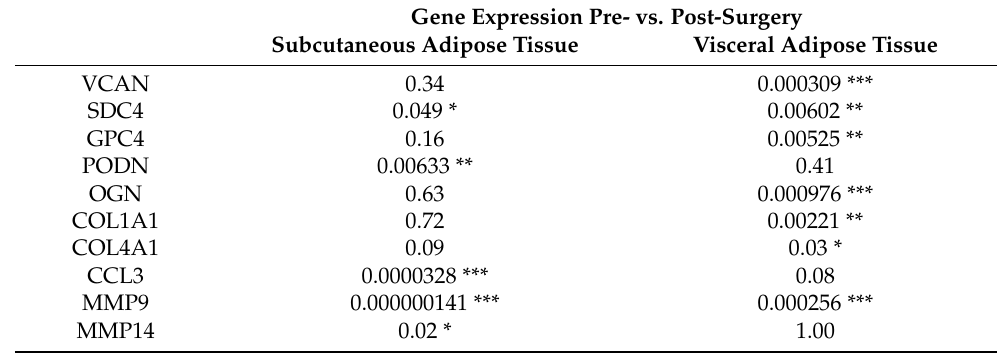
Table 4. p -values of versican (VCN), syndecan 4 (SDC4), glypican 4 (GPC4), podocan (PODN), and osteoglycan (OGN) in subcutaneous (SC) and visceral (VIS) adipose tissues pre- and post-surgery in Human Cohort 2. mRNA expression is variance stabilizing transformation (VST) normalized. A Kruskal–Wallis one-way ANOVA was applied and for pairwise comparisons, Dunn’s test was used and corrected for multiple inferences using the Hommel method. Gene Expression Pre- vs. Post-Surgery